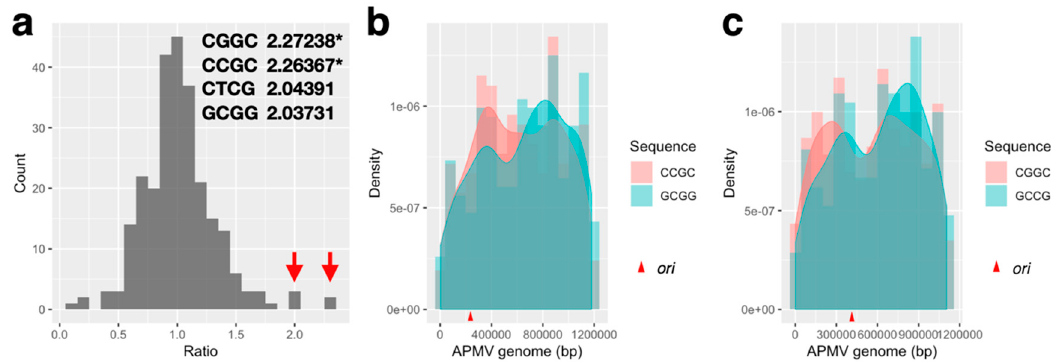
Figure 5. Comparative analysis of the quartet nucleotide composition ratio between the ori -containing region and the total genome of APMV. ( a ) Frequency distribution of fold-changes (= [ ori -containing region]/[whole genome], ori -containing region: 375–385 kb of AY653733.1). Red arrows indicate that the fold-changes of the bins are greater than two. Sequences and fold-changes greater than two are listed on the top right of the figure. Asterisks indicate significant outliers from the population calculated by Grubbs test ( p <0.05). ( b , c ) Density graph of the 5 (cid:48) -CCGC-3 (cid:48) /5 (cid:48) -GCGG-3 (cid:48) and 5 (cid:48) -CGGC-3 (cid:48) /5 (cid:48) -GCCG-3 (cid:48) on the APMV genome (AY653733.1). Red arrowhead on the scale indicate the estimated location of the ori region (382,000 ± 5000 bp).